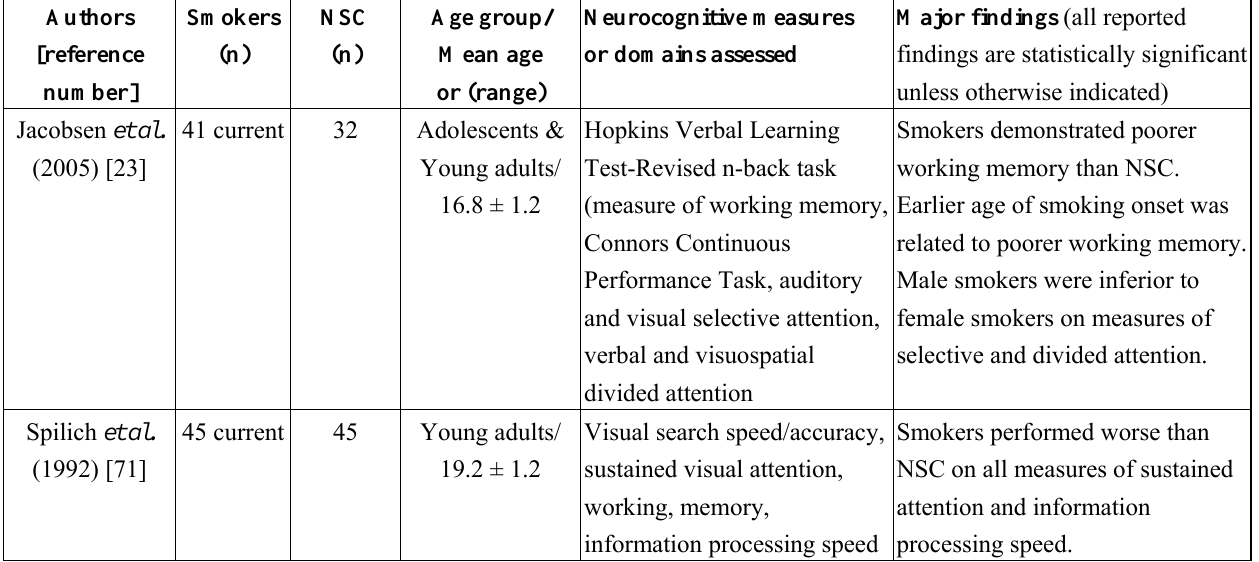
Table 1. Neurocognitive studies of chronic smoking in adults (sorted by age group, then year of